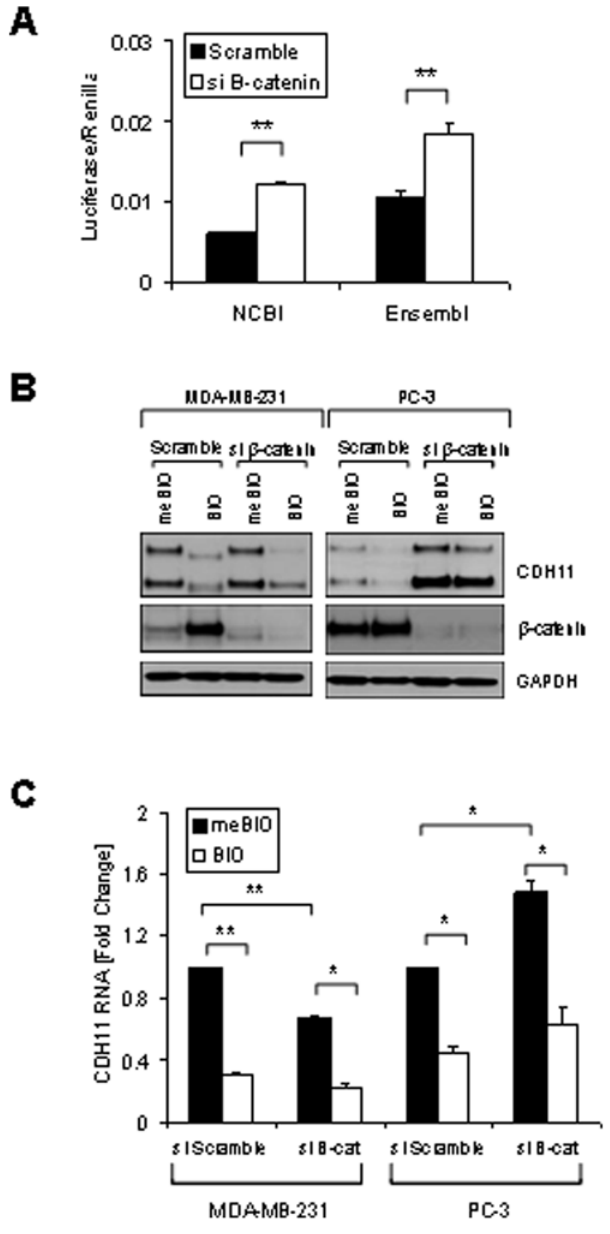
Figure 5. b -catenin as a regulator of cadherin-11 expression. A: PC-3 cells were transfected with pGL3-CDH11-3 9 UTR NCBI or pGL3- CDH11-3 9 UTR Ensembl and pCMV-Renilla and along with either non- specific siRNA or siRNA directed against CTNNB1. 48 hours after transfection cells were were lysed using passive lysis buffer and luciferase activity was analyzed. Luciferase activity was normalized to renilla activity. (** indicates a p-value . 0.001). B: MDA-MB-231 and PC- 3 cells were transfected with either non-specific scrambled siRNA (siScramble) or siRNA directed against CTNNB1 (si b -cat). 24 hours after transfection cells were treated with 1 m M BIO or meBIO (control). 48 hours after transfection protein was isolated for Western blot analysis. C: MDA-MB-231 and PC-3 cells were transfected with either non-specific scrambled siRNA (siScramble) or siRNA directed against CTNNB1 (si b -cat). 24 hours after transfection cells were treated with 1 m M BIO or meBIO (control). 48 hours after transfection RNA was isolated for real-time PCR analysis. (* indicates a p-value . 0.05; ** indicates a p-value . 0.005)